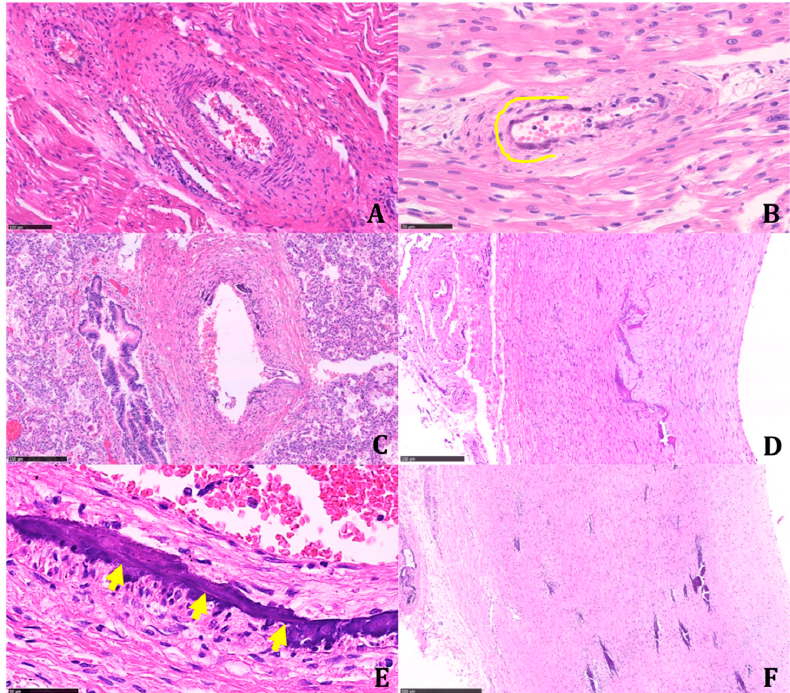
Figure 4. Different degrees of vascular calcified lesions and their intravascular localization observed in the same patient. The simultaneous presence of early and late-stage lesions suggests that this disease changes over time. ( A ) Vessels histologically not affected by calcifications (H&E; 19.2 × ). ( B ) A small intramyocardial artery with minimal subendothelial calcifications (along yellow line) (H&E; 40 × ). ( C ) Intrapulmonary artery with initial gross calcifications of the internal elastic lamina (H&E; 10.3 × ). ( D ) Thoracic aorta with calcifications interposed between the muscular wall and the thick neointima; calcifications extend into the latter and minimally into the muscularis tunica (H&E; 11.2 × ). ( E ) Renal artery; details of parietal calcification in the inner elastic lamina: the arrows indicate its presence as a thin, purple line (H&E; 61.7 × ). ( F ) Diffuse calcifications throughout the thickness of the aortic wall (H&E; 7.17 × ). All histological preparations were digitized and photographed with Nanozoomer 360, Hamamatsu. (Scale bars: A: 100 µ m; B: 50 µ m; C: 250 µ m; D: 250 µ m; E: 50 µ m; F:500 µ